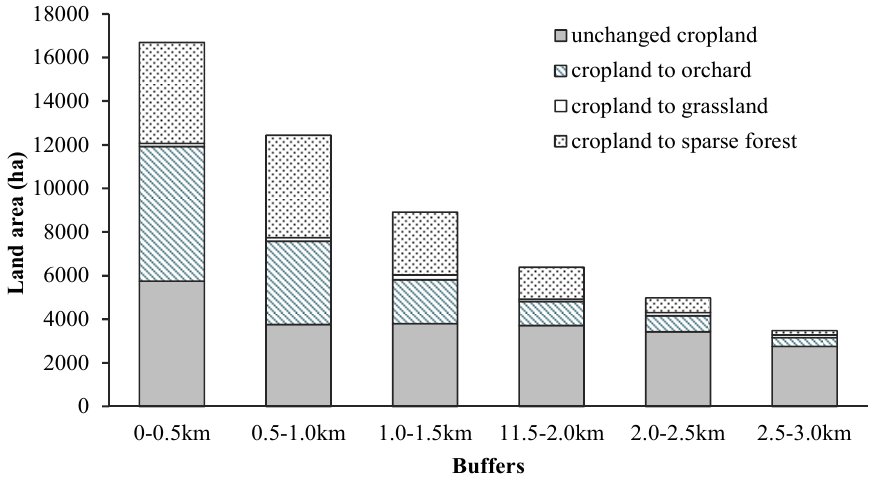
Figure 5. Distribution of converted cropland in each buffered belt referring to the main roads.